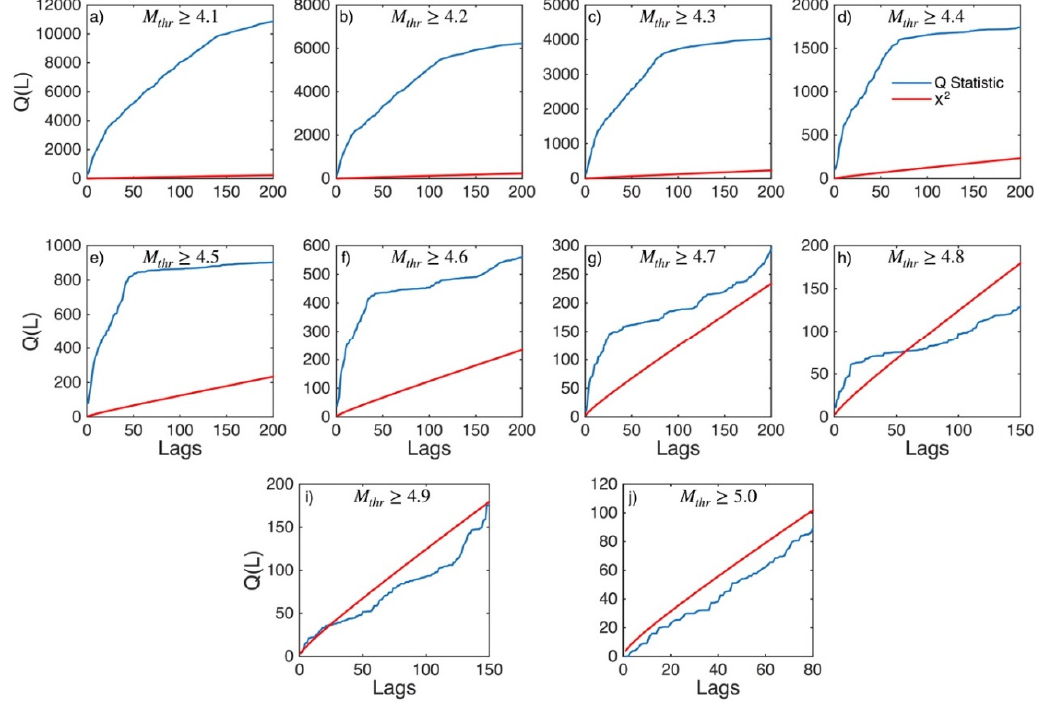
Figure A9. Statistics of Ljung–Box Q-test (blue lines) and the critical values for the X 2 distribution (red lines) for Eastern Hellenic Arc (sub − area 4) for magnitude thresholds ( M thr ) varying from 4.1 to 5.0 (subplots a – j ).